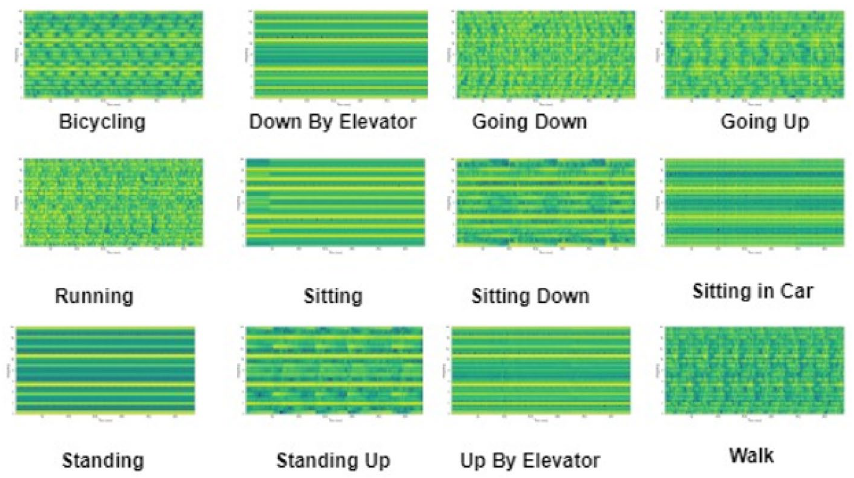
Figure 8. Spectrogram images for various human activities from the HuGaDB